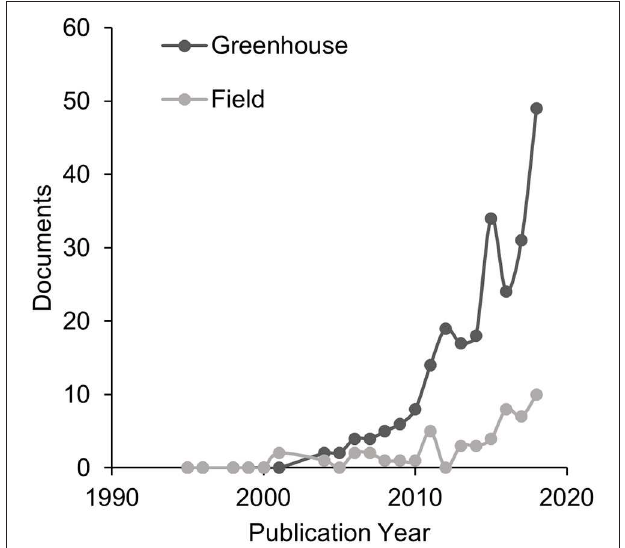
FIGURE 1 | A Scopus search performed on March 18, 2019 for “plant-soil feedback” OR “plant-soil feedbacks” in abstract, title, or keyword of published articles from 1995 to 2018 demonstrated an exponential increase in PSF research over the past 20 years. Dark gray indicates greenhouse studies and gray indicates field